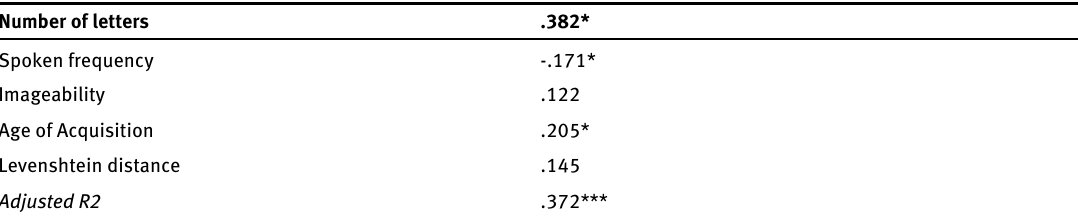
Table 6: Standardized regression coefficients (β) for a multiple regression analyses carried out on lexical decision times